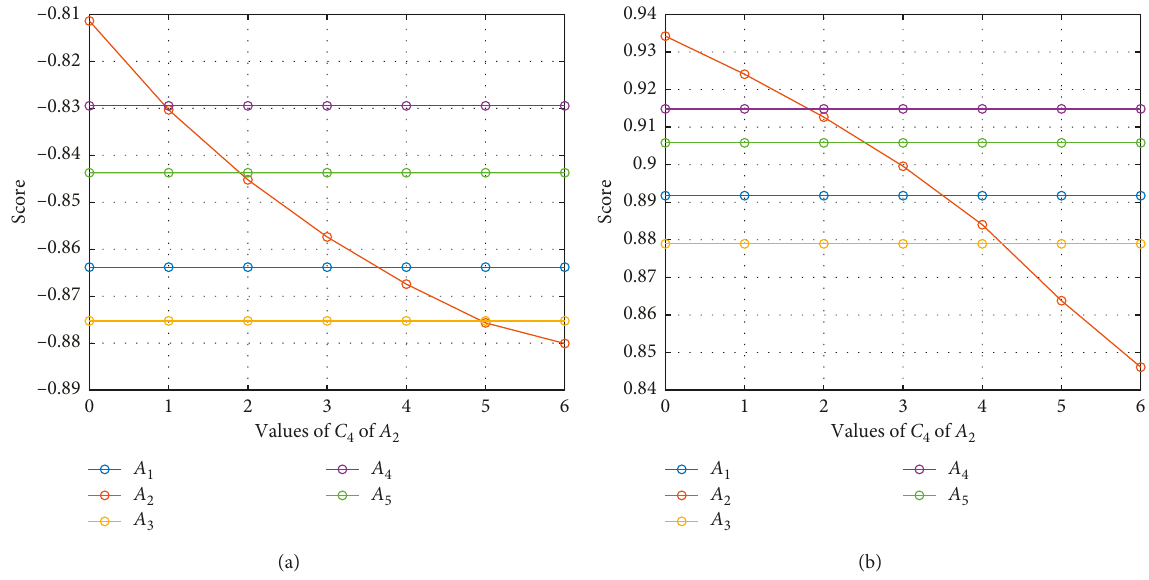
Figure 5: The change of the places of A 2 in the rankings of the group of WBMs [41] and the group of WGBMs [41]. Scores of the five companies computed by the group of (a) qROFWBMs and (b)